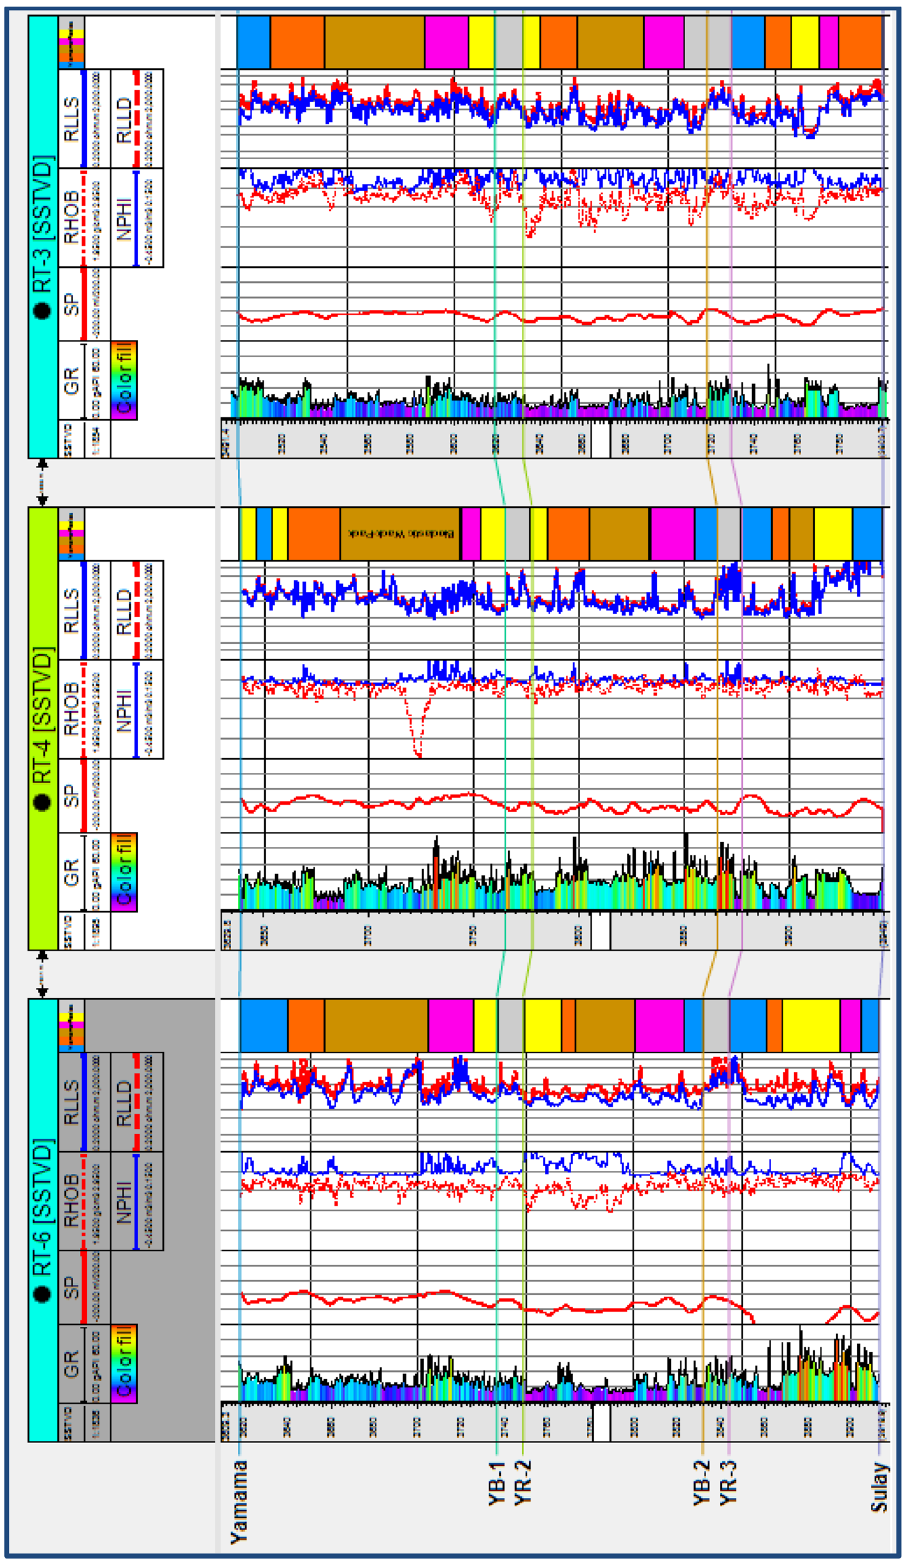
Fig. 4 Cross section for wells Rt-4, 3, and 6 in the Yamama